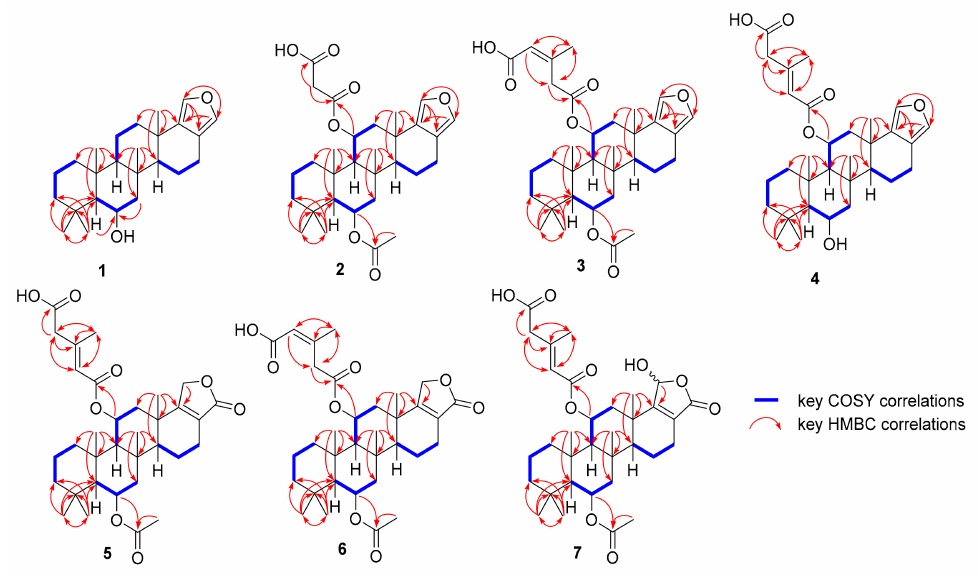
Figure 2. Key 2D NMR (COSY and HMBC) correlations of sesterterpenoids 1 – 7 .